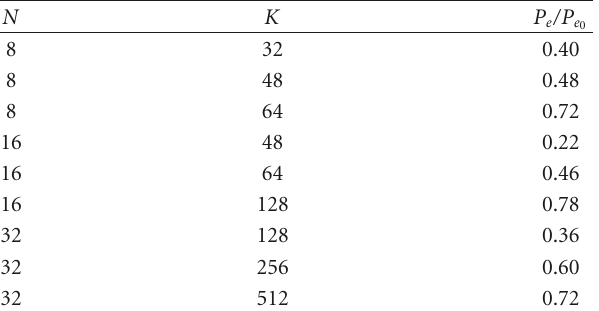
Table 1: The ratio P e /P e homogeneous clutter.